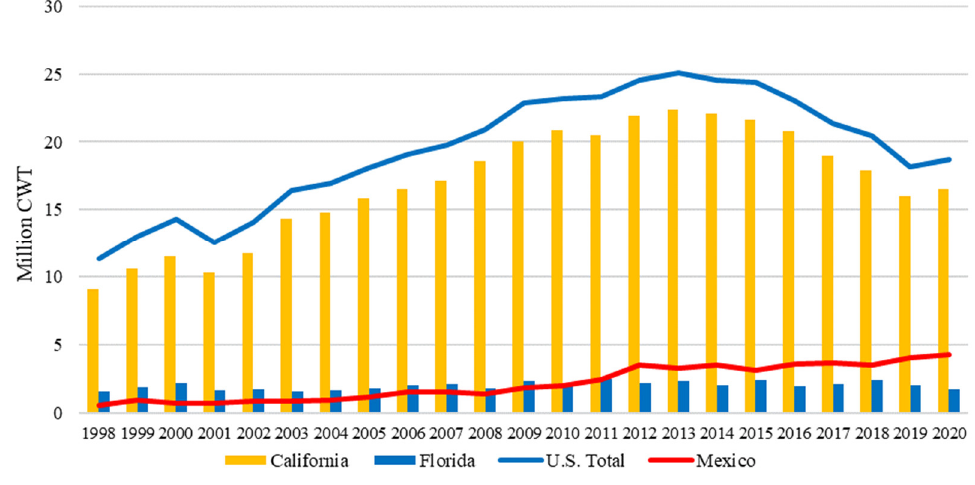
Figure 7. U.S. production and Mexican imports: fresh strawberry. Notes: The fresh strawberry production data of California from 2019 and 2020 and Florida from 2017 to 2020 are undisclosed and calculated based on the percentages of fresh strawberries from available data; on average, 77% of California and 100% of Florida total production were sold to the fresh market. Sources: USDA FAS [11]; USDA NASS [37].